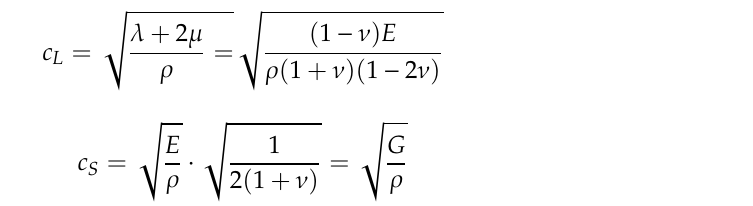
Table 1. Material parameters and wave velocity calculation results.